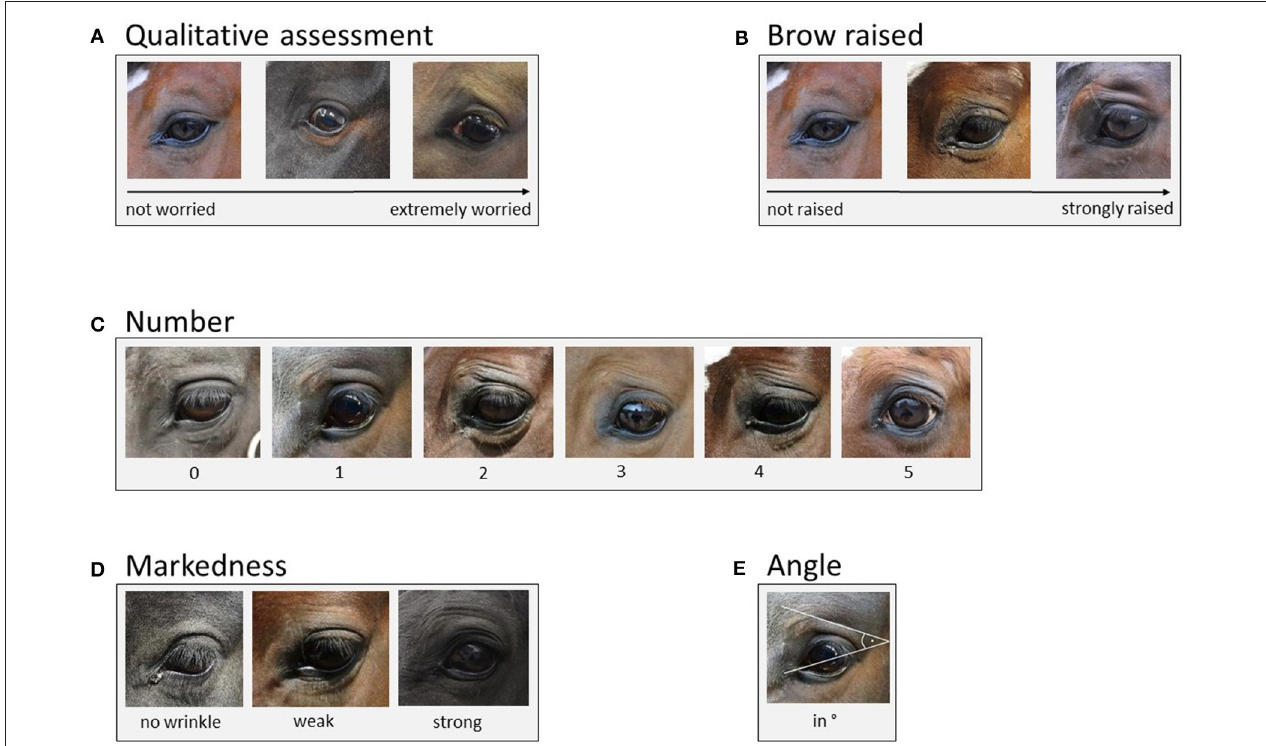
FIGURE 1 | Eye wrinkle assessment scale [adapted from (1)]. (A) Qualitative assessment: The overall first subjective impression of the eye area with respect to how “worried” the horse actually looks as assessed on a Visual Analogue Scale ranging from “not worried” to “extremely worried.” (B) Brow raised: The amount the skin above the eye (brow region in humans) is raised, assessed on a Visual Analogue Scale ranging from “not raised” to “strongly raised.” (C) Number: Only wrinkles above the eye and those of a minimum length of one third of the eyeball’s diameter are considered. A deep indent, often seen in thin horses, is not considered as a wrinkle (as it is not caused by the contraction of the muscles underlying the inner brow raiser). Moreover, wrinkles originating on the eyelid are not counted. (D) Markedness: The depth and width of the wrinkles is assessed. If the markedness differs between wrinkles, the most prominent wrinkle is assessed. “No wrinkle”: no wrinkle visible. “Weak”: wrinkles are flat and narrow lines. “Strong”: wrinkles are pronounced in depth and width. (E) Angle: The degree of the angle is measured at the intersection of the extension of a line drawn through the eyeball and the extension of the topmost wrinkle. The line through the eyeball extends from the medial to the lateral corner of the eyeball. If the medial corner is not clearly defined, the line goes through the middle of the tear